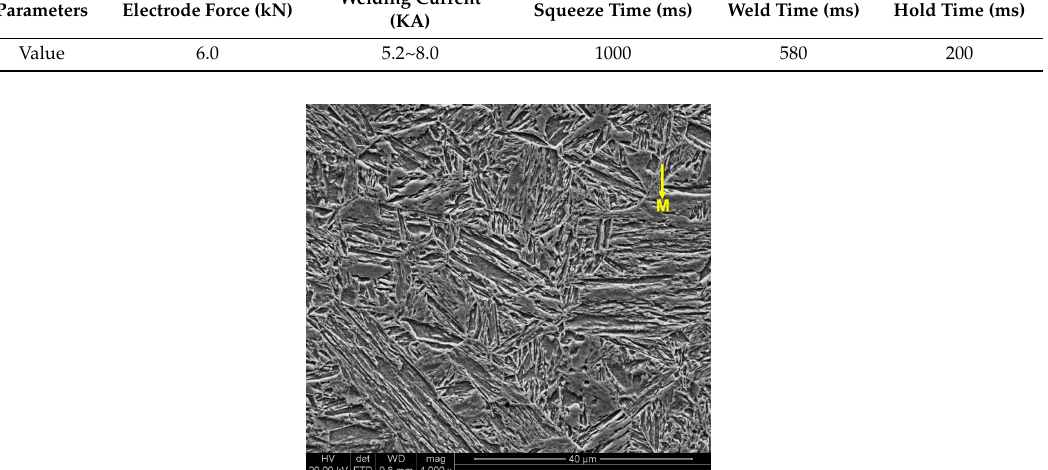
Figure 1. Microstructures of the B1500 steel.